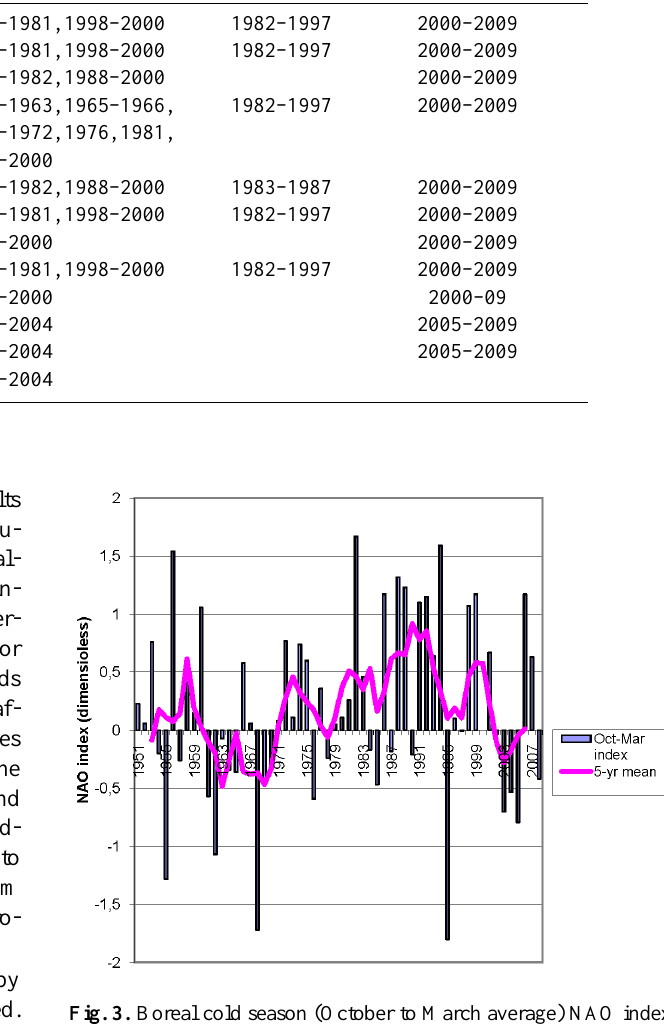
Fig. 3. Boreal cold season (October to March average) NAO index from 1950–1951 to